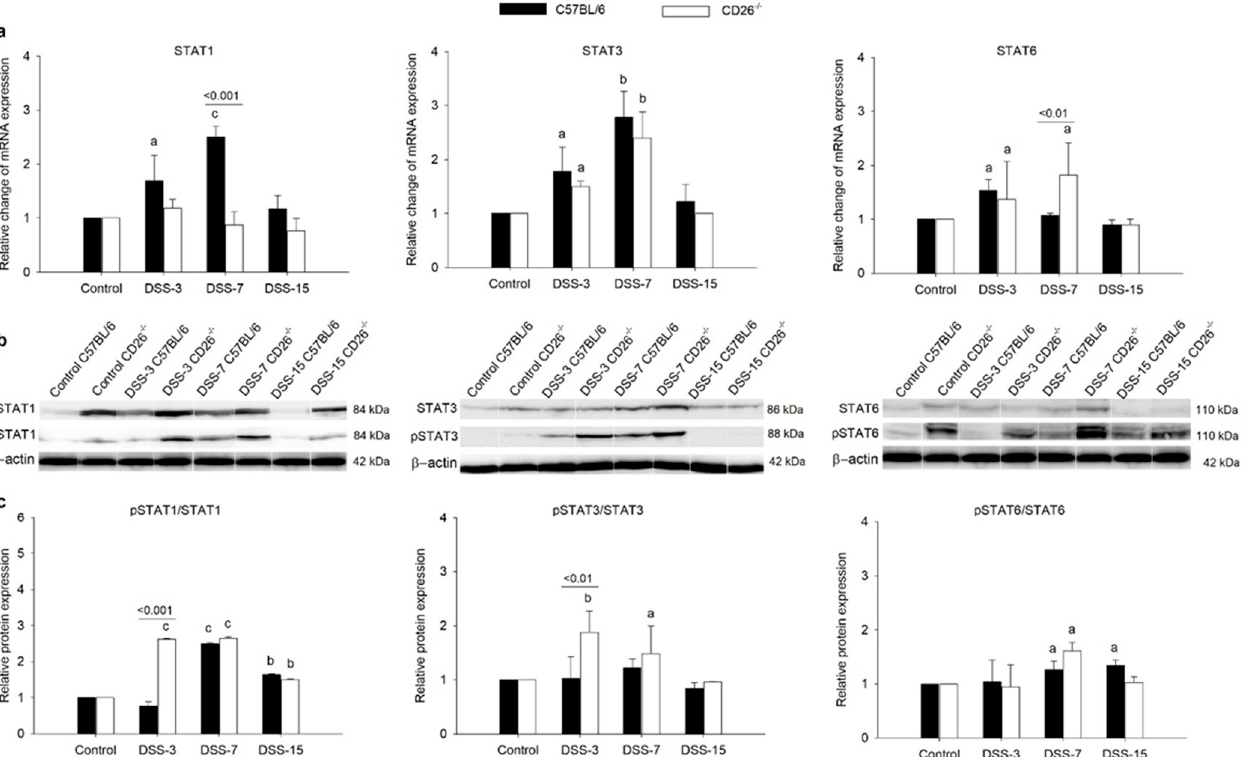
Figure 5. The influence of CD26 deficiency on mRNA and protein expression of STAT transcription factors in colonic tissue during dextran sulfate sodium (DSS)-induced colitis ( a ) Relative quantification of STAT1, STAT3, and STAT6 genes expression in colonic tissue of C57BL/6 and CD26 − / − mice with DSS-induced colitis was determined by quantitative real-time (RT)-PCR on days 3, 7, and 15 days after colitis induction. The RT-PCR analysis was performed in duplicate. ( b ) Protein expression of STAT1, STAT3, and STAT6 and their phosphorylated forms in colonic tissue of C57BL/6 and CD26 − / − mice with DSS-induced colitis was performed by Western blot analysis on days 3, 7, and 15 days after colitis induction. ( c ) Relative quantification of the expression ratio of proteins phospho-STAT1 and STAT1, phospho-STAT3 and STAT3, and phospho-STAT6 and STAT6. Data are expressed as mean ± SD. n = 6 mice/each group. a, b, and c denote p < 0.05, p < 0.01, and p < 0.001 compared with the control group, respectively. Comparisons between related DSS-treated C57BL/6 and CD26 − / − groups are highlighted by horizontal lines above the bars.